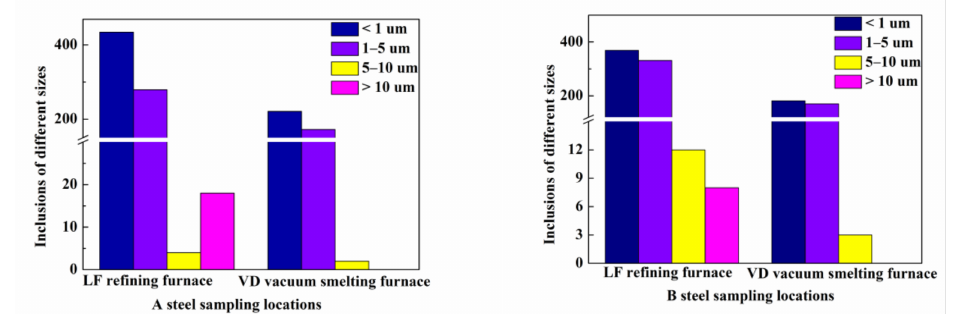
Figure 4. The number of inclusions of different sizes in different working